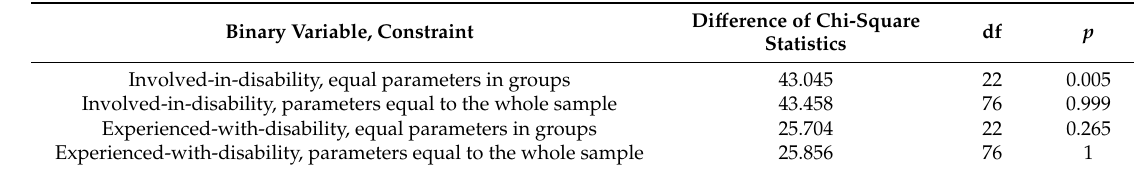
Table 7. Characteristics and goodness-of-fit statistics for the four-factor model.